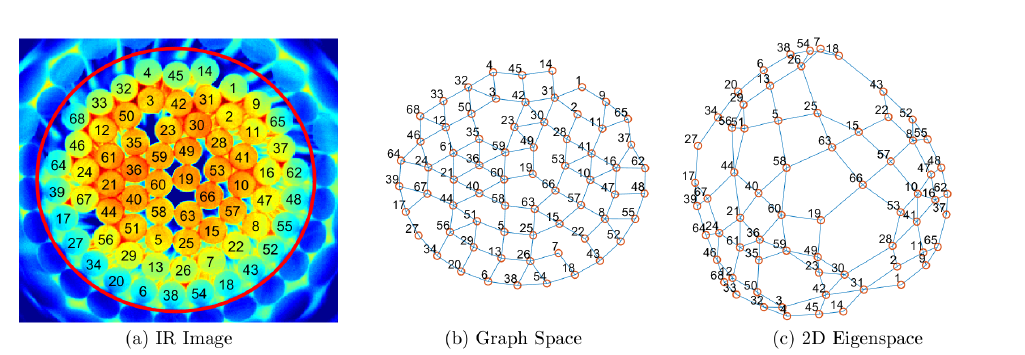
Figure 2. IR image of rod assembly with rods numbered ( a ), along with the corresponding connections between rods in graph space ( b ), and eigenspace ( c